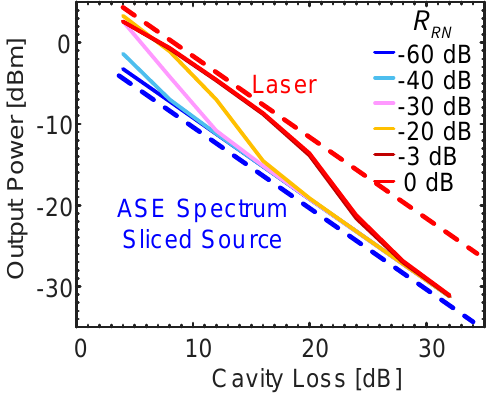
R and cavity loss on the optical output power RN R and the losses, the source could be an ASE RN